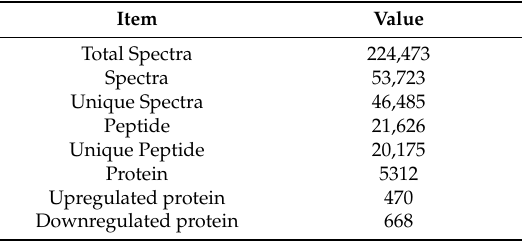
Table 1. Overview of proteomics sequencing